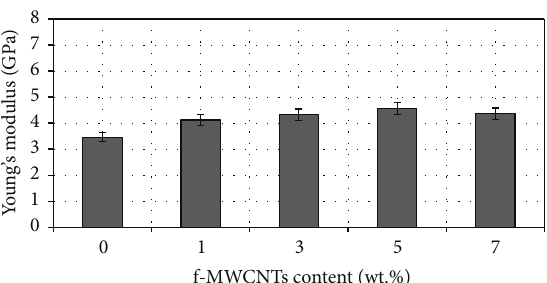
Figure 8: Effect of f-MWCNTs on impact strength of nanocompos- ites.